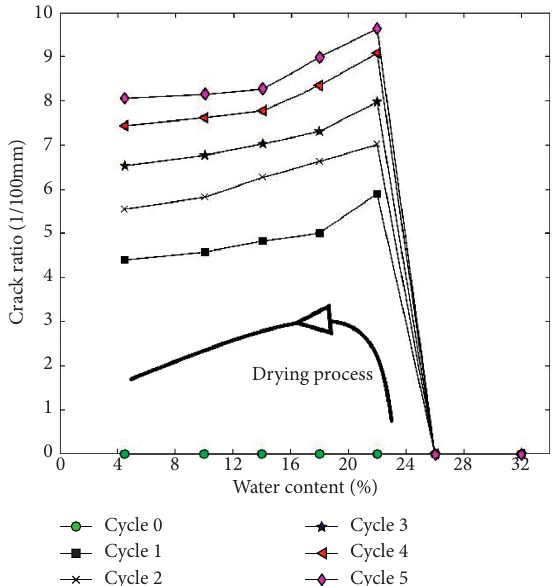
Figure 6: Relationship between crack ratio and water